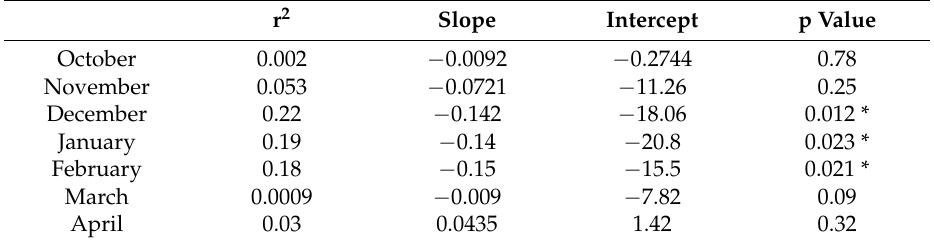
Table 2. The significance of trend analysis in monthly mean air temperature over the last 31 years at the Chinggis Khan International Airport (60 km from the study area). r r 2 Slope